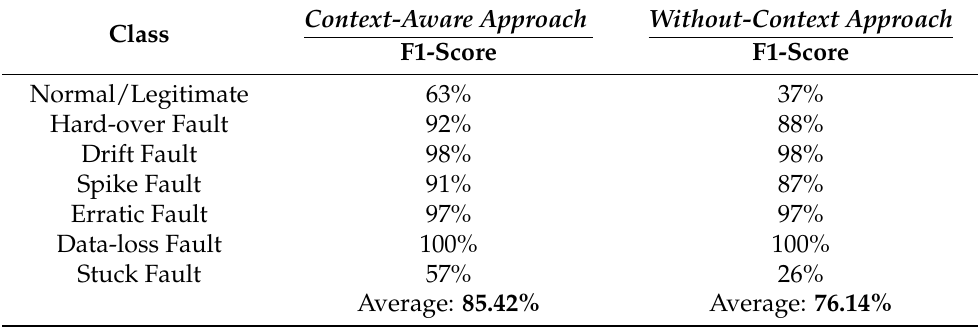
Table 4. ET F1-score comparison of individual classes on context-aware approach vs. without- context approach.